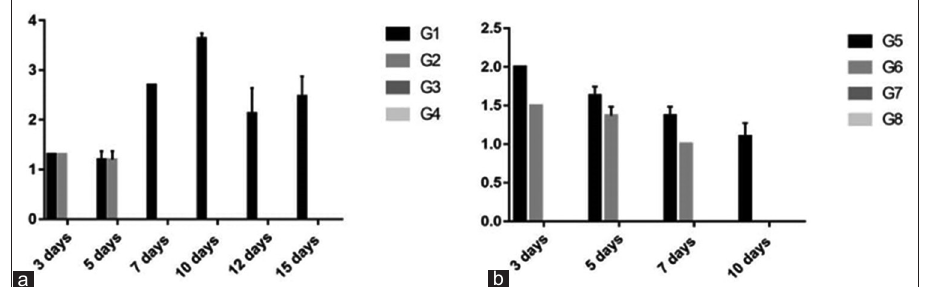
a Figure-6: Column chart showing virus titration in egg (expressed as log 10) from cloacal swabs in different groups and different time conditions. (a) experiment 1, (b) experiment 2.